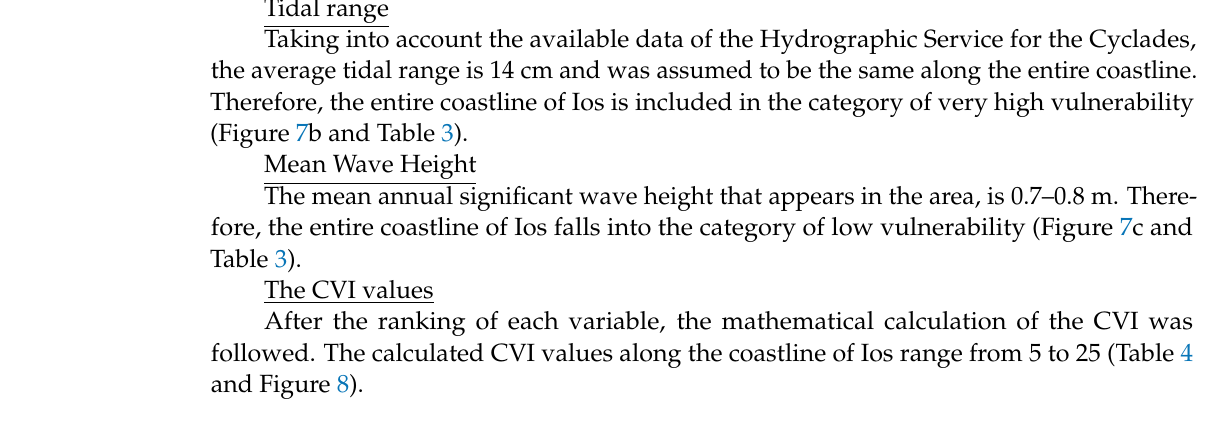
Figure 7. Map of vulnerability ranking of the physical variables: (a) Relative Sea Level change; (b) Tidal range; (c) Mean Wave Height. Table 3. Ranking of the physical variables: (a) Relative Sea Level change; (b) Tidal range; (c) Mean Wave Height. The tables indicate the length, in km and percentage, of coastline in each category of vulnerability.